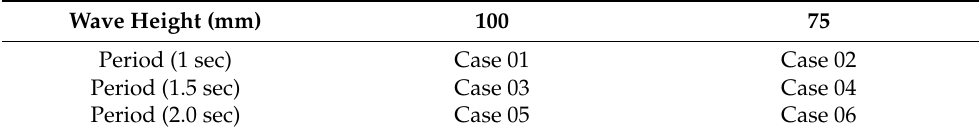
Table 2. Wave-period and wave-height-parameter generated by the wave